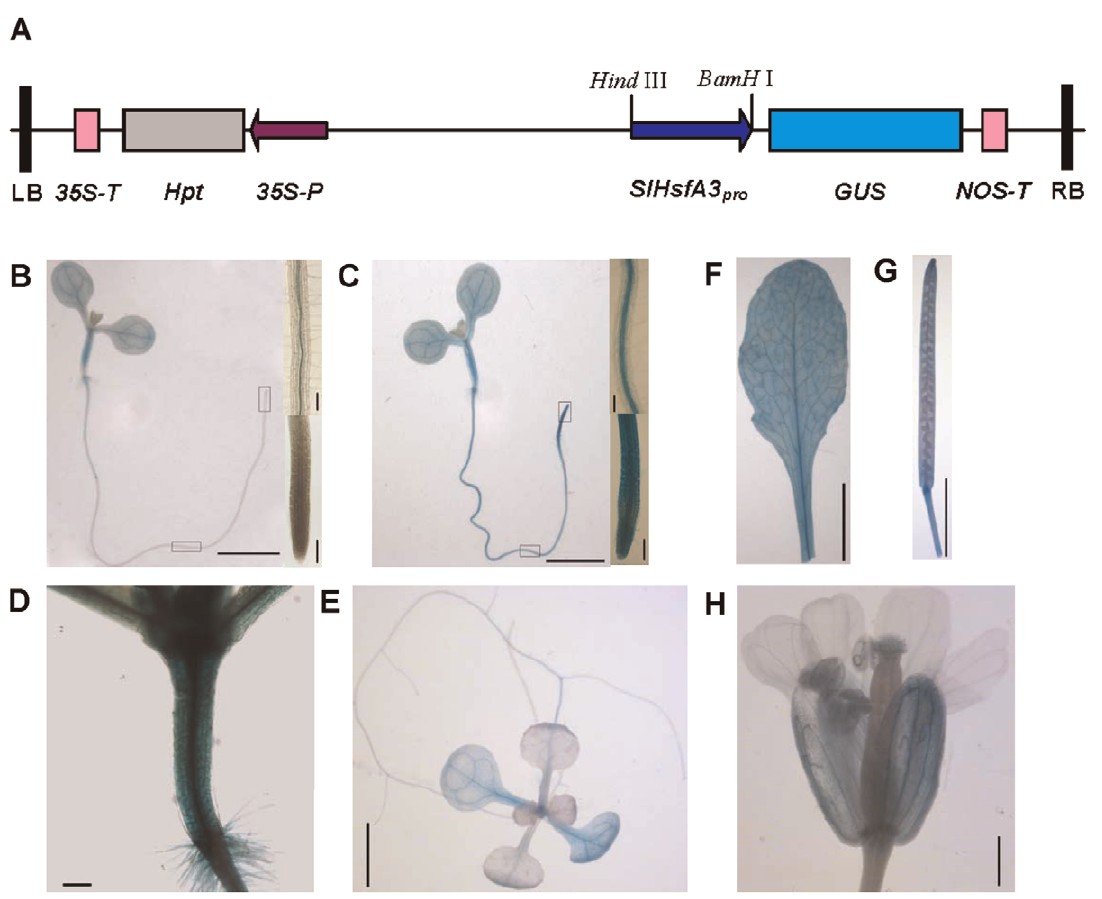
Figure 3. Histochemical analysis of GUS expression driven by SlHsfA3 promoter in transgenic Arabidopsis . (A) Schematic diagram of construct used for agroinfiltration. (B–C) Six-day-old seedlings untreated (B) and heat stressed (C). For heat stress procedures, see Methods. Bars=2 mm. The corresponding sections of vascular and meristematic tissues in root are boxed in (A) and shown by higher magnification on the right side. Bars=100 m m. (D) Hypocotyl. Bar=100 m m. (E) Twelve-day-old seedling. Bar=2 mm. (F) Rosette leaves. Bar=5 mm. (G) Mature siliques. Bar=5 mm. (H) Flower. Bar=500 m m.